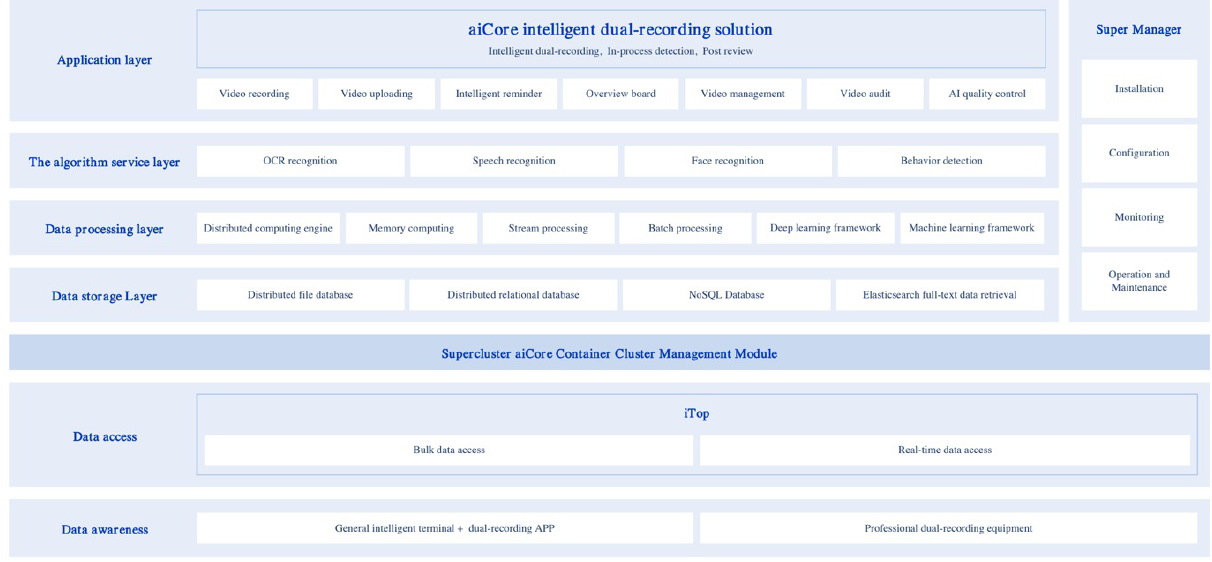
Fig. 3 AiCore intelligent dual-recording solution architecture diagram based on AIoT